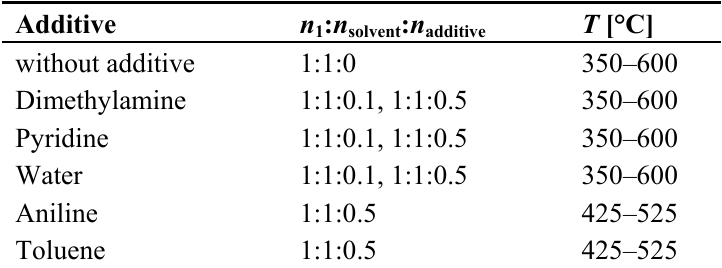
Table 4. List of pyrolysis experiments (solvent: n -heptane).